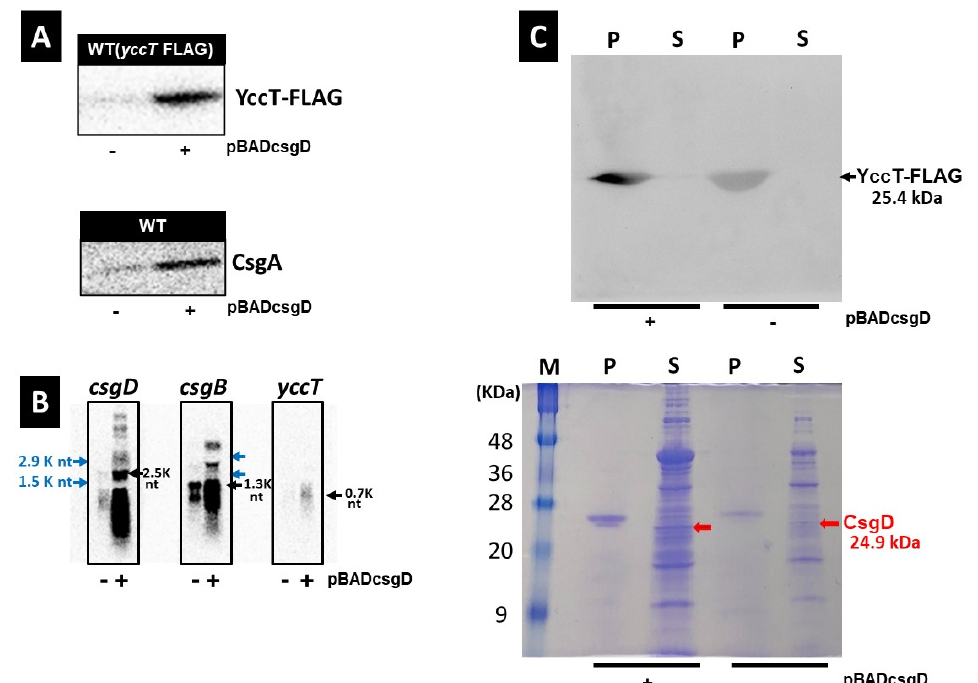
Figure 3. Effects of high CsgD expression on curli synthesis genes and YccT expression. ( A ) YccT-FLAG (upper panel) and CsgA (lower panel) expression in the BWWYTF(BW25113 YccT-FLAG) strain containing the control pBAD18 ( − ) or pBADcsgD (CsgD) vector. CsgA detection involved pretreating the samples with 90% formic acid (FA) and dried before resuspension in sample buffer. Anti-FLAG tag and anti-CsgA peptide antibodies were used to detect YccT-FLAG and CsgA via Western blot. ( B ) The expression of csgD (left panel), csgB (middle panel), and yccT (right panel) mRNAs in the BWWYTF(BW25113 YccT-FLAG) strain transformed with the control vector pBAD18 ( − ) or pBADcsgD (CsgD) is detected through Northern blot. ( C ) BWWYTF(BW25113 YccT-FLAG) strains containing the control vector pBAD18 ( − ) or pBADcsgD (CsgD) is shake cultured at 28 ◦ C for 16 h in YESCA medium in the presence of L-arabinose (final concentration 0.02%). The periplasmic (P) and spheroplast (S) fractions are separated via ultracentrifugation after lysozyme processing. YccT-FLAG expression is detected by Western blot (upper panel) using an anti-FLAG tag antibody. The individual fractions are analyzed by Coomassie staining after SDS–PAGE (lower